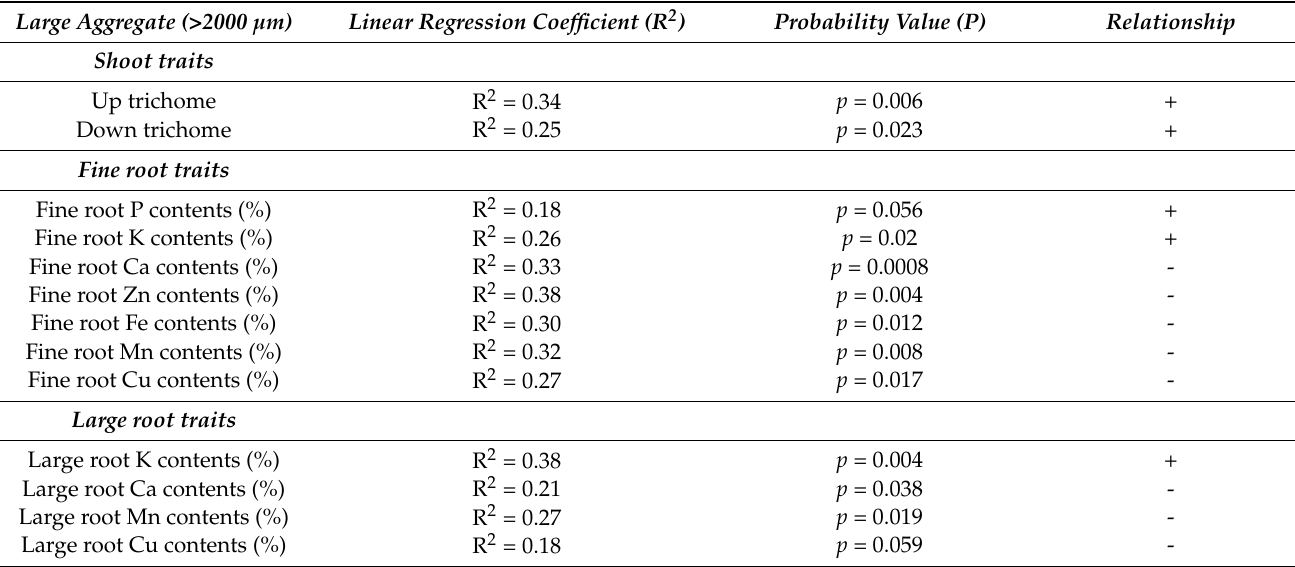
Table 1. Relationship between abundance of large macroaggregates (>2000 μm) and plant traits.